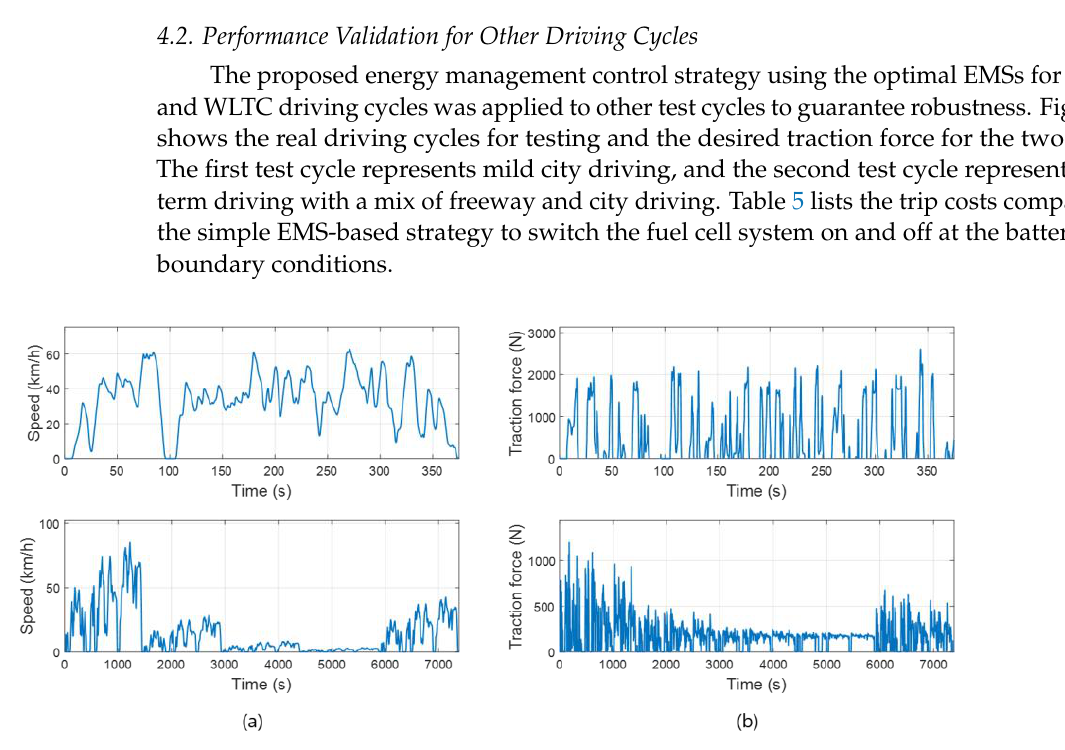
Figure 10. Test driving cycle for validation: ( a ) Driving cycle v v ; ( b ) Desired traction force F tract . Table 5. Trip costs of the simple EMS and the proposed-based EMS for the test cycles. Cycle Name SOC batt,init